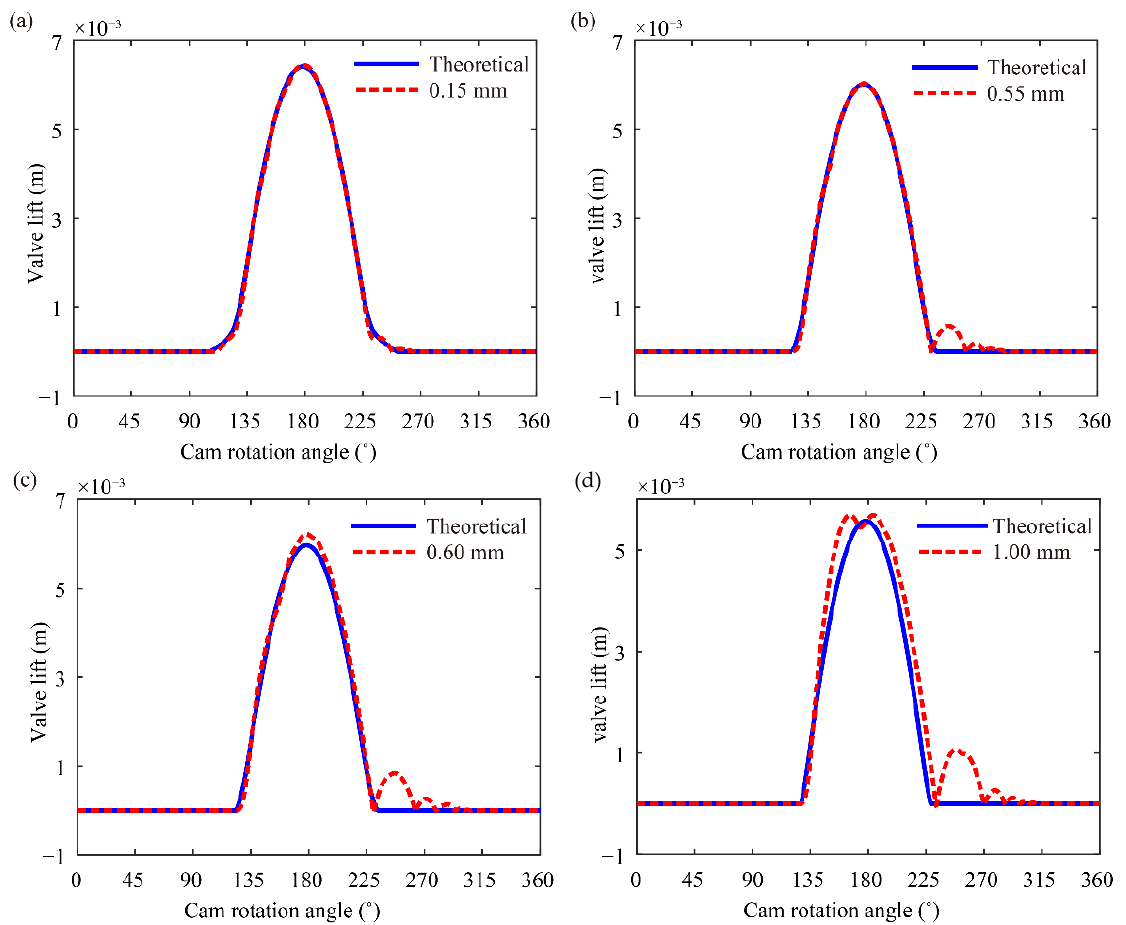
Figure 9. Comparison of the jump phenomenon at different valve clearances: ( a ) 0.15 mm, ( b ) 0.55 mm, ( c ) 0.60 mm and ( d ) 1.00 mm.